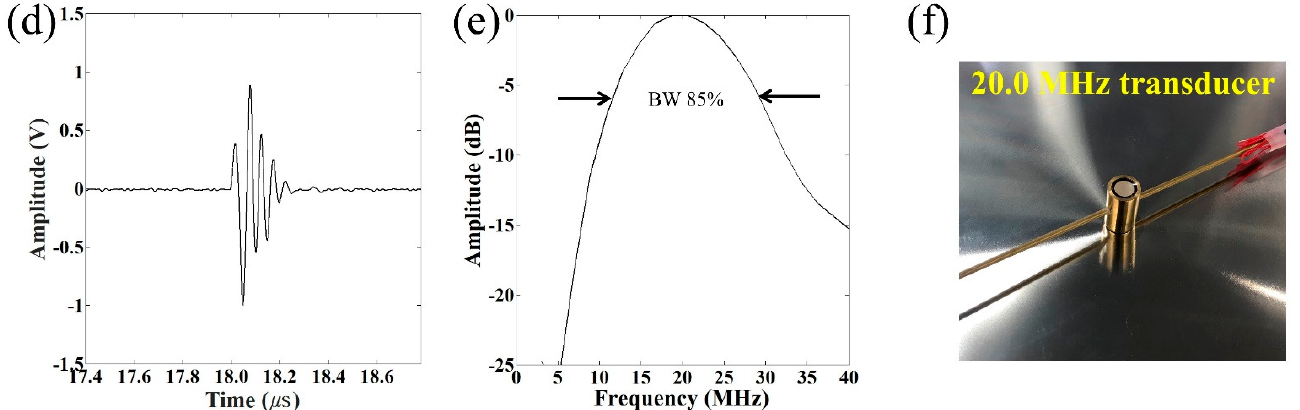
Figure 2. Pulse-echo response measurements and frequency spectra of 5.3 MHz and 20.0 MHz different-frequency transducers. ( a ) Echo response of a 5.3 MHz transducer; ( b ) frequency spectrum of a 5.3 MHz transducer; ( c ) photograph of the transducer of a 5.3 MHz transducer; ( d ) echo response of a 20.0 MHz transducer; ( e ) frequency spectrum of a 20.0 MHz transducer; and ( f ) photograph of the transducer of a 20.0 MHz transducer.